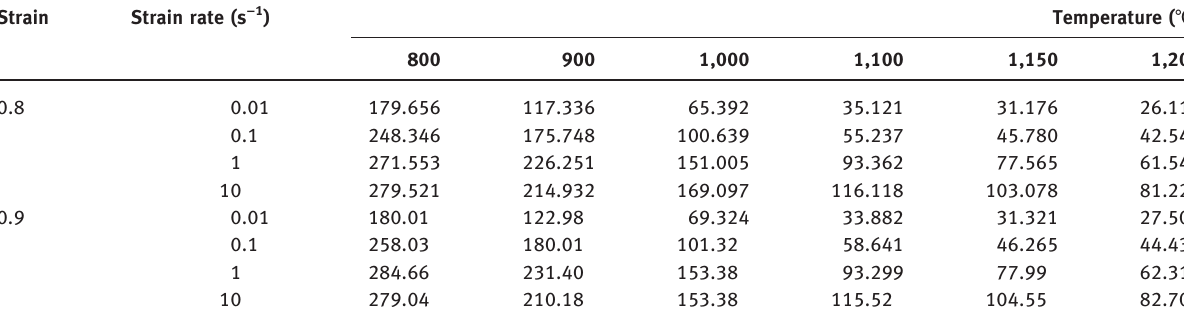
Table 3: Flow stress value of Aermet 100 under different deformation conditions. Strain Strain rate (s − 